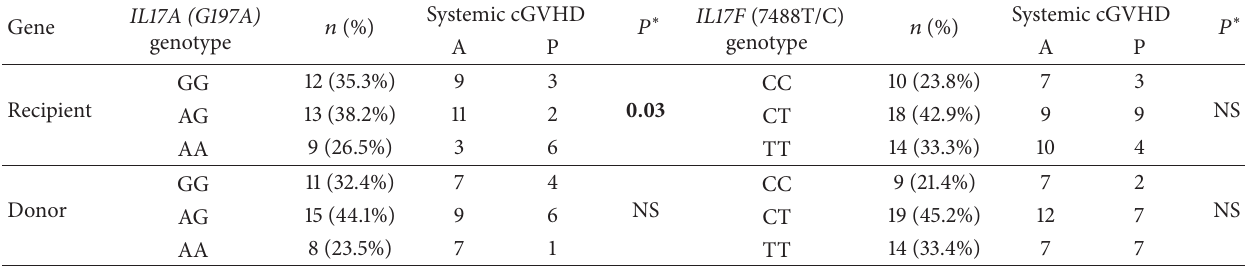
Table 2: Association between recipient and donor IL17A ( 𝑛 = 34 ) and IL-17F ( 𝑛 = 42 ) genotypes and occurrence of systemic cGVHD. IL17A (G197A) Gene